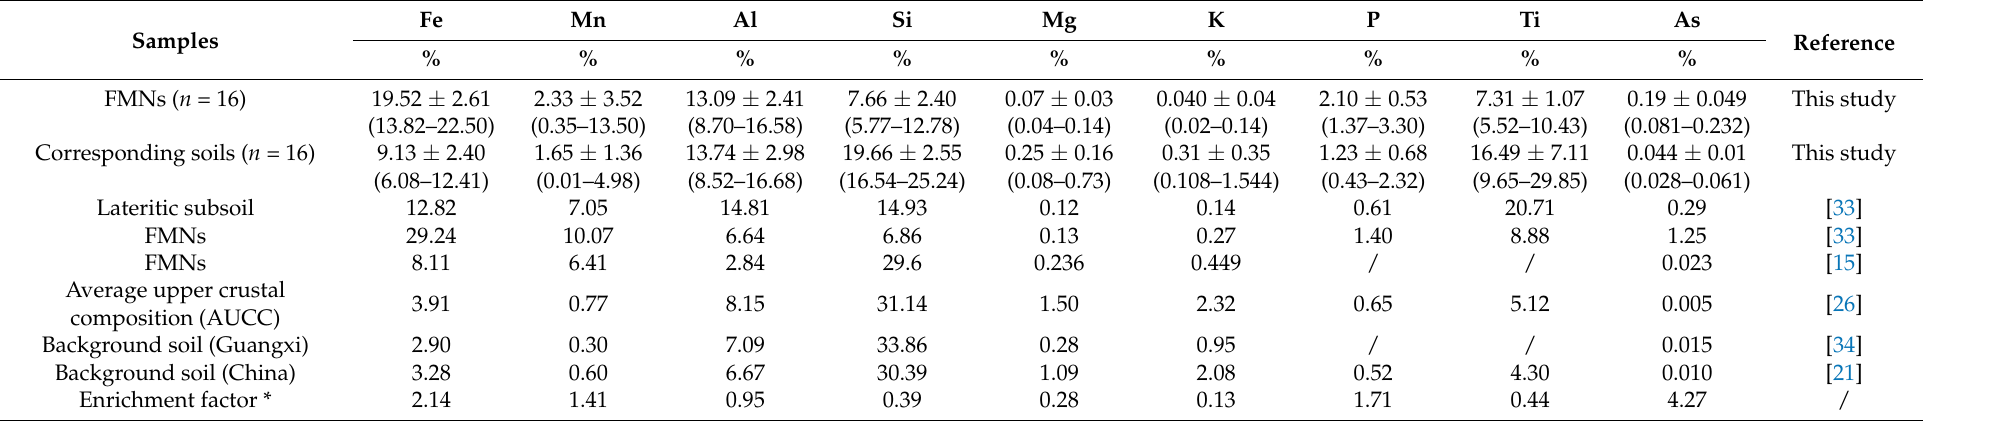
Table 1. Concentrations of elements in FMNs and the corresponding